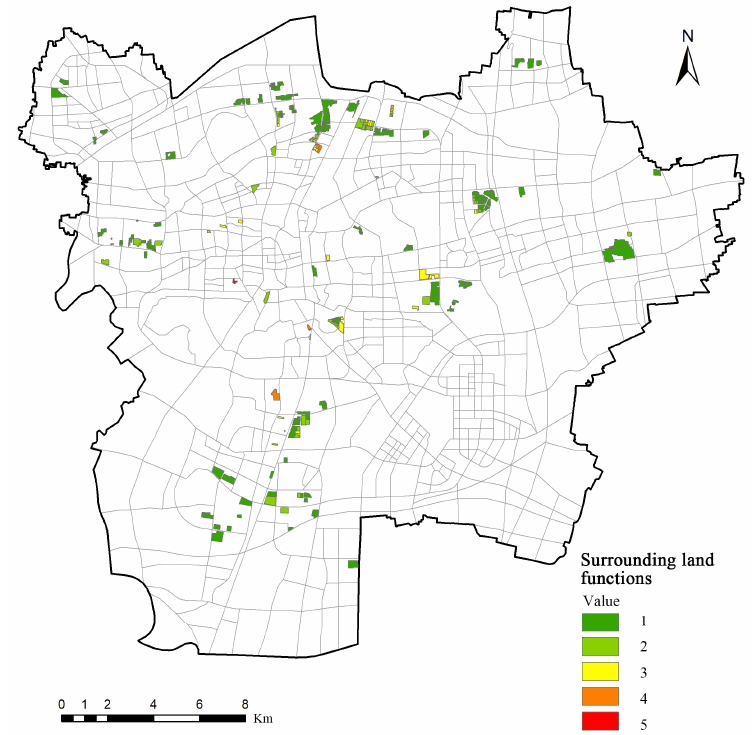
Figure A6. Single value of site suitability based on “Surrounding land functions”.